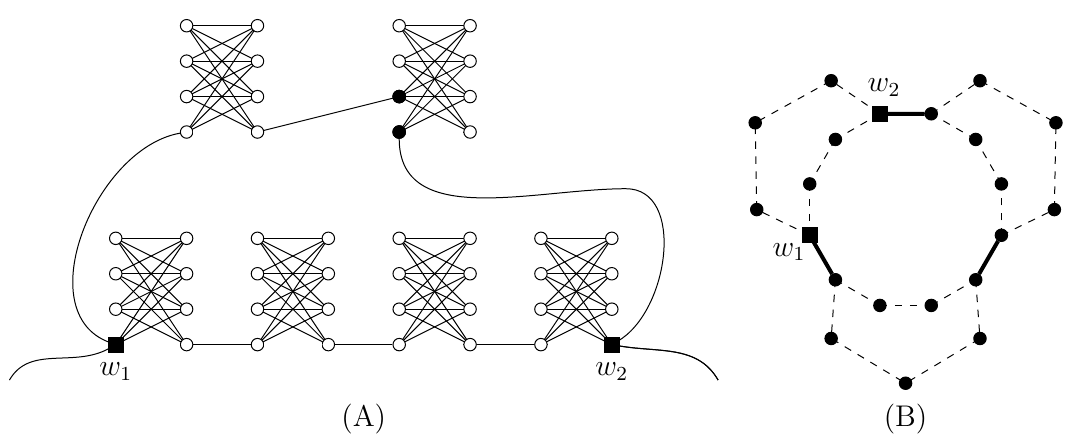
Figure 7: Illustration (A) is the subgraph (or gadget) used to construct a nearly-4-regular, 2-connected graph with proper connection number greater than 2. Each of the three dashed 7-cycles from graph (B) would be replaced by the gadget from (A). The square vertices indicate identified vertices. Once all three 7-cycles are replaced by the gadget, the resulting graph is 2-connected with proper connection number greater than 2 and all vertices have degree 4 or